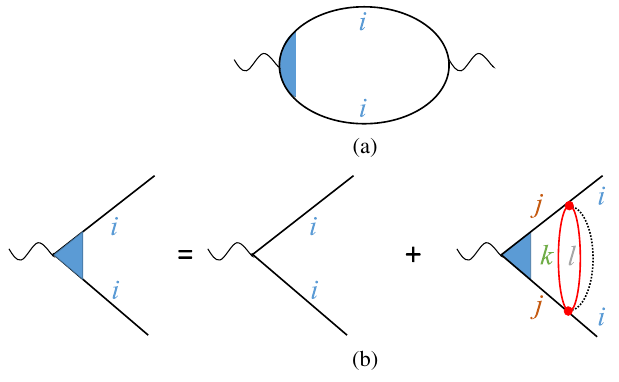
Ω Þ . Wiggly xx ð k ; ω Þ [ G k ; ω Þ ]. (b) The c ð f ð